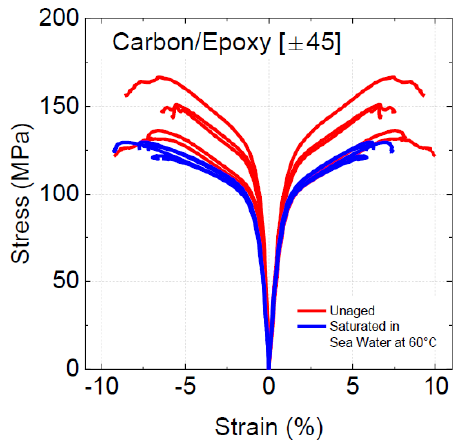
Fig.4. In-plane shear behaviour